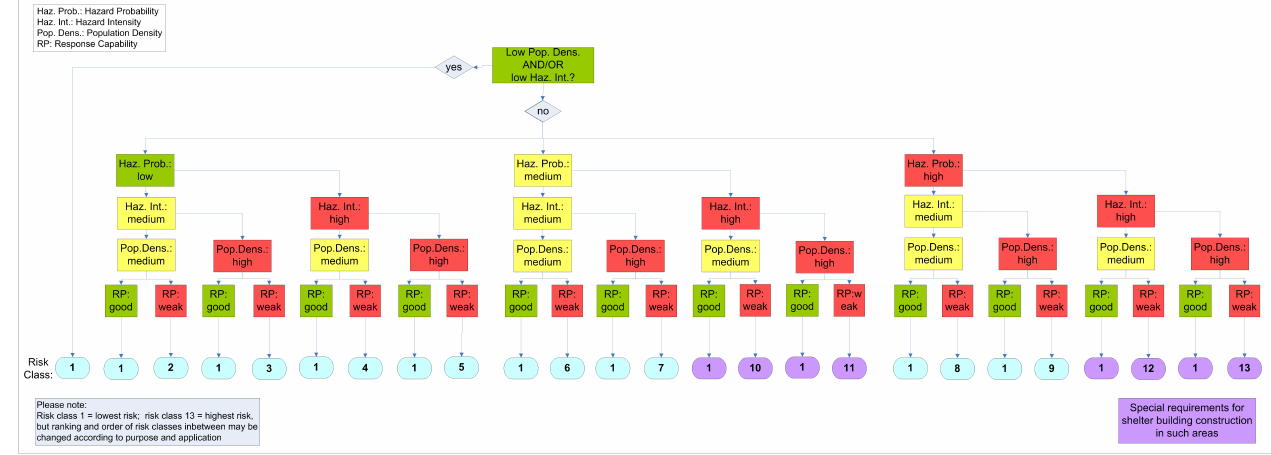
Fig. 4. Decision tree for determination of risk